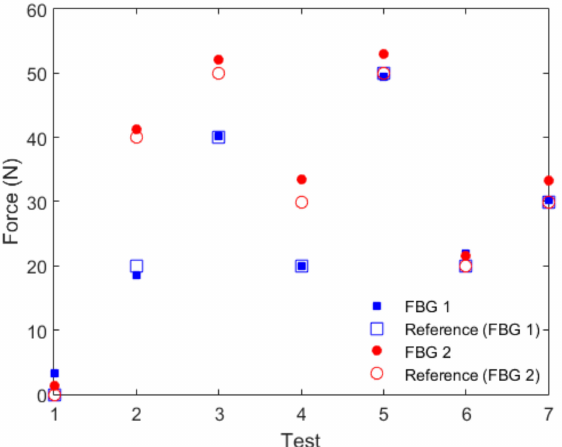
Figure 10. Validation tests for FBGs 1 and 2 at different forces and temperatures, where tests 1–3